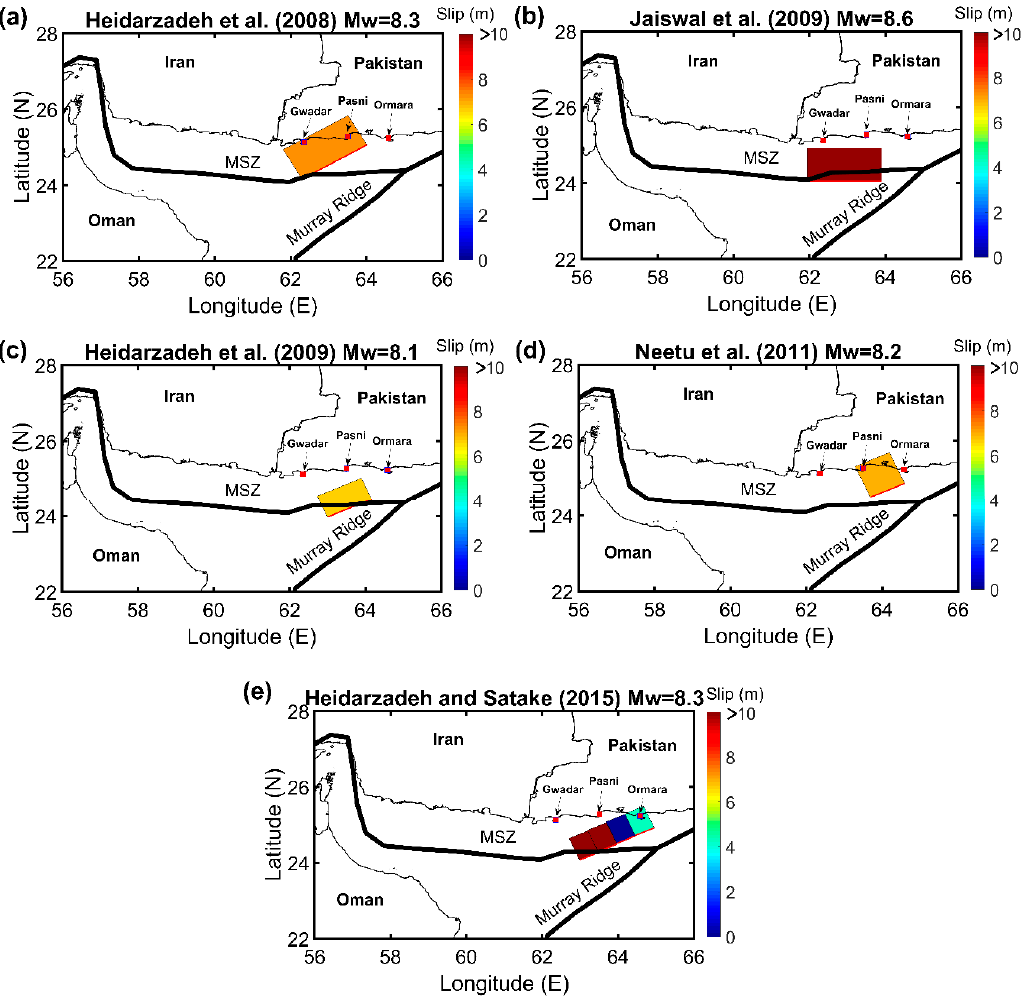
Figure 2. Different tsunami source models for the 1945 Makran event. ( a ) Heidarzadeh et al. (2008), ( b ) Jaiswal et al. (2009), ( c ) Heidarzadeh et al. (2009), ( d ) Neetu et al. (2011), and ( e ) Heidarzadeh and Satake (2015).